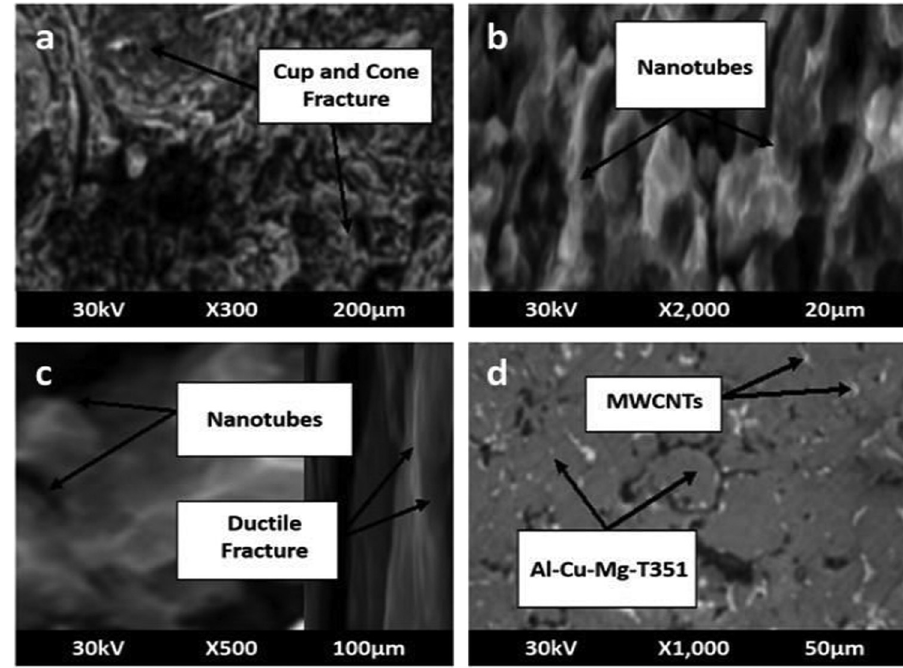
Figure 14: SEM image of Al – Cu – Mg – T351 + MWCNT, ( a ) tensile fracture with cup - cone failure, ( b ) sintered - heat treated surface with MWCNT fracture, ( c ) enlarged image of the X, and ( d ) sintered - heat treated surface with the distribution of nanotubes at the grain